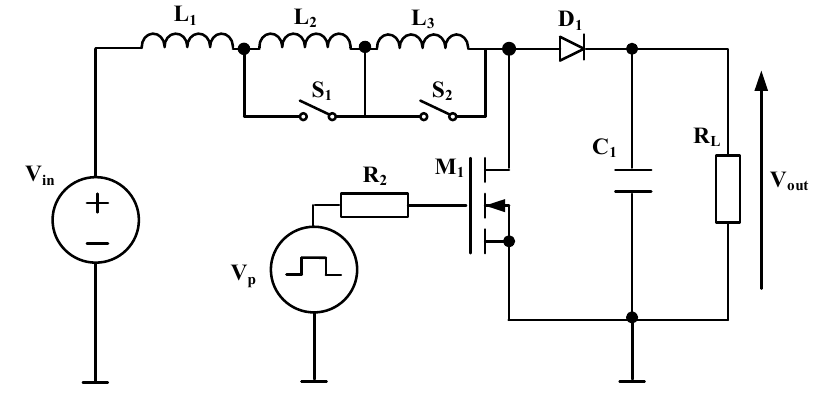
Figure 17. Analysed circuit of a boost converter.